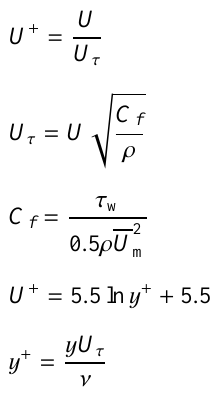
Fig. 16 Cross-streamwise profile of the mean streamwise velocity at x / d = 30 ( U 0 = 12.9 m / s). Next, we estimated the wall shear stress (cid:28) w from the mean velocity gradient in the viscous sub-layer with the follow- ing equations (Wygnanski, et al.,